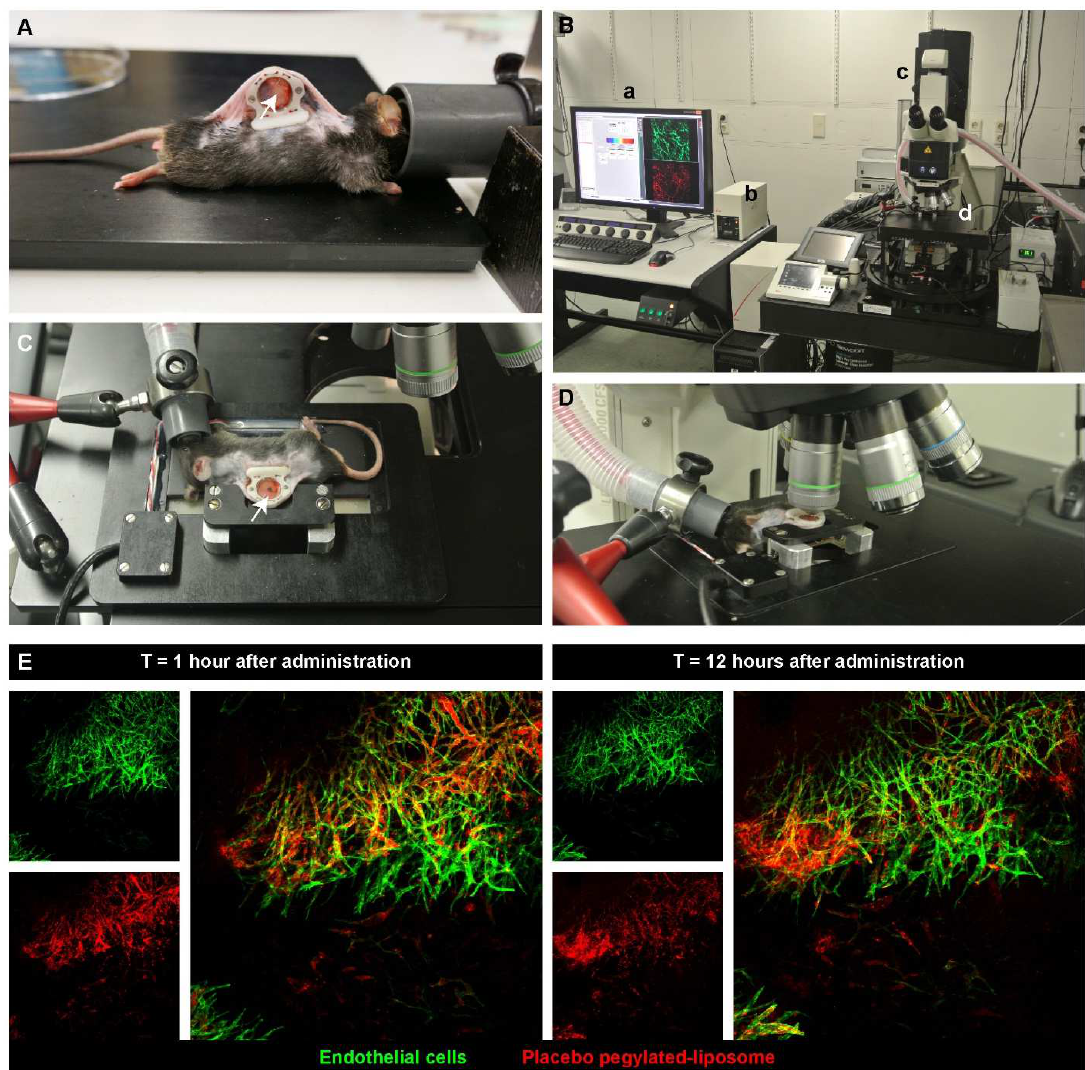
Figure 3. Imaging of a tumor by intravital microscopy. ( A ), Mouse after transplantation of a Lewis lung carcinoma (arrow) in a dorsal skinfold chamber. ( B ), Intravital microscope set up, a = computer and software, b = fluorescent light for fast scanning, c = confocal/multiphoton microscope, d = adapted table with heating platform and anesthesia connection. ( C ), Mouse with a B16BL6 melanoma tumor (arrow) fixated on a heated platform, ( D ), Mouse under the microscope ready for imaging, ( E ), intravital images of a Lewis lung carcinoma in a transgenic mouse with green fluorescent endothelial cells and injected with a red fluorescent placebo pegylated liposome. Images are taken 1 and 12 h after systemic administration.